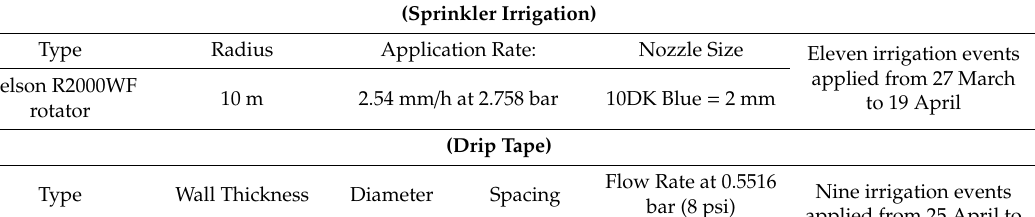
Table 3. Sprinkler irrigation and drip tape system specifications.